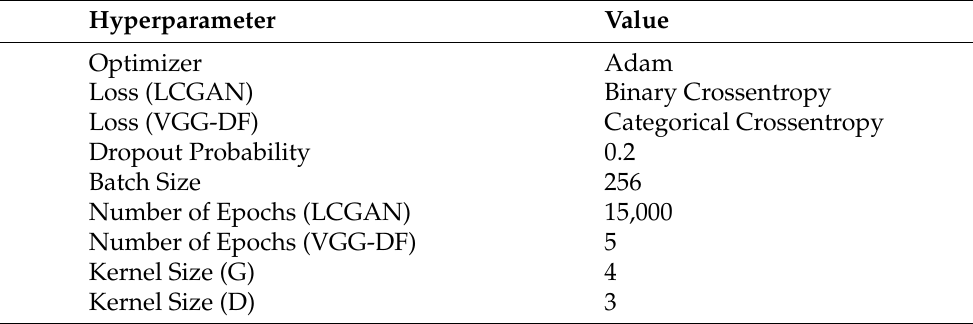
Table 1. Hyperparameter settings of